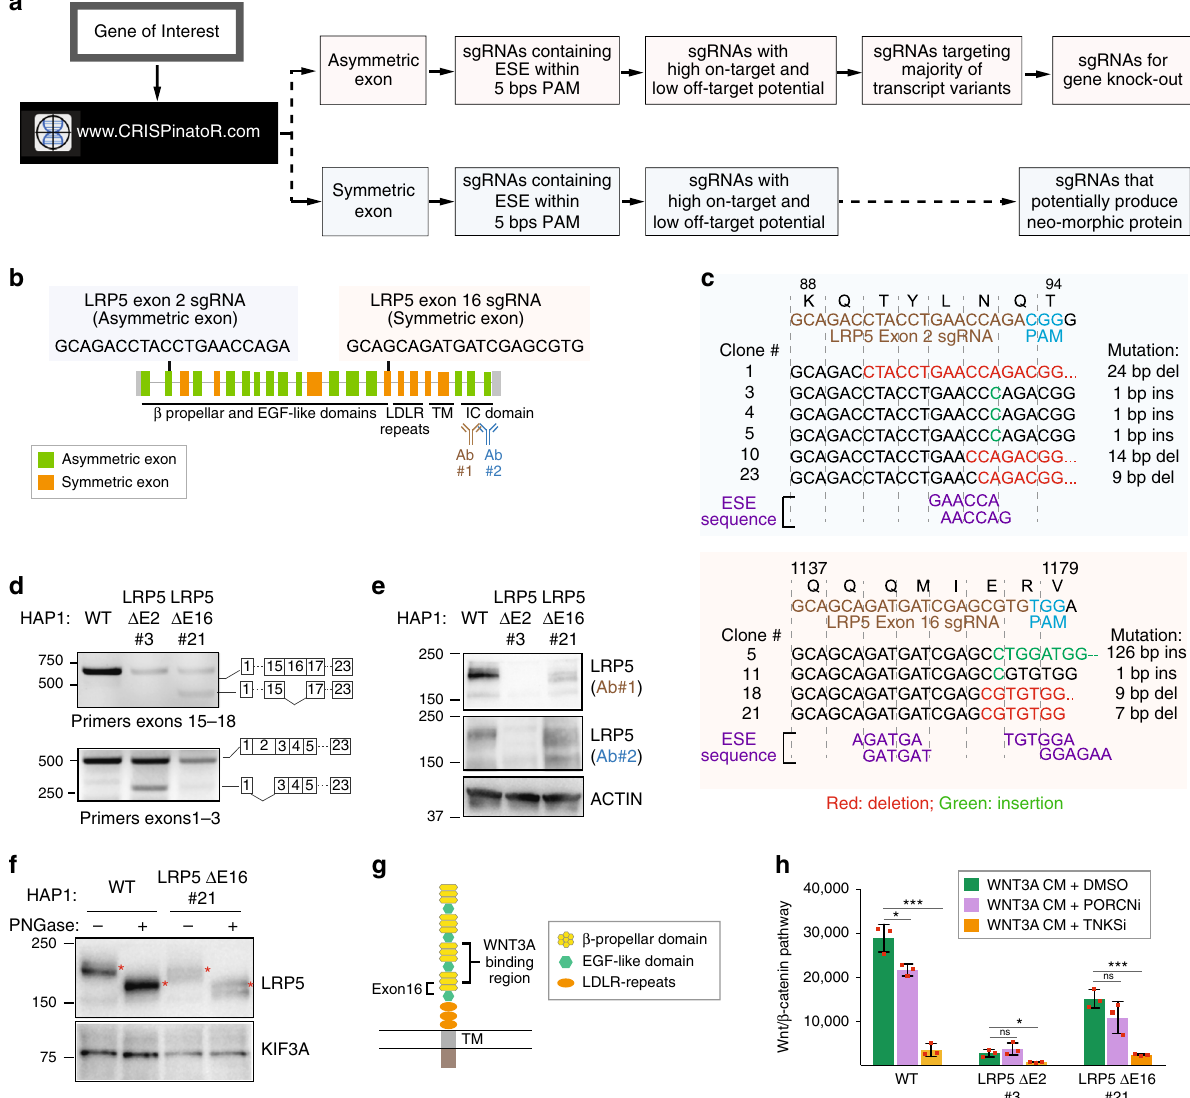
Fig. 5 Targeting RNA-regulatory elements for gene knockout agendas. a CRISPinatoR: a web-based guide RNA design tool that utilizes targeted ESE disruption for achieving gene elimination. CRISPinatoR identi fi es sgRNA sequences that target ESEs in asymmetric exons and calculates off-targeting potential and the number of splice variants impacted by the sgRNAs. A scoring system that integrates all three parameters is used to provide sgRNAs with high gene knockout potential. b Genome structure of the LRP5 gene and sgRNA sequences targeting the asymmetric exon 2 and the symmetric exon 16. c Genomic sequencing results of HAP1 clones edited using LRP5 exon 2 and exon 16 sgRNAs. CRISPR-introduced mutations and the putative ESE sequences are indicated. d Exclusion of an asymmetric or a symmetric exon with INDEL-induced changes to the putative ESE sequences. RT-PCR analysis and cDNA sequencing result of HAP1 cells edited with LRP5 exon 2 and exon 16 sgRNAs. e Targeted ESE disruption in asymmetric exon increases gene knockout potential. Western blot analysis of HAP1 clones edited with LRP5 exon 2 sgRNA (Clone 21) and exon 16 sgRNA (Clone 3) was probed with two distinct antibodies indicated in “ b ” . ESE disruption in symmetric exon 2 produces internally truncated in-frame LRP5 protein. f The internally truncated LRP5 protein is glycosylated. Lysates derived from WT or LRP5 Δ E16 HAP1 cells were incubated with the deglycosidase PNGase F then subjected to western blot analysis. g Exclusion of LRP5 exon16 would delete a sequence adjacent to the WNT3A binding domains. h The LRP5 Δ E16 protein formed post skipping of a symmetric exon is functionally active. WNT/ β -catenin pathway activity in response to WNT3A conditioned medium (WNT3A CM) was measured for HAP1 WT, LRP5 Δ E2, and LRP5 Δ E16 cells. WNT pathway inhibitors WNT974 (PORCNi) and IWR1 (TNKSi) serve as negative and positive control, respectively. All error bars represent mean of triplicates ± s.d. The experiment was repeated three times with similar results. Statistical testing was performed using Student ’ s t -test, * P < 0.05, ** P < 0.01, *** P < 0.001, **** P < 0.0001. Source data are provided as a Source Data fi for evaluating the potential effects of INDELs on mRNA regulation. Materials and methods INDELs. All the cell lines were tested for mycoplasma contamination. None of the Cell lines and reagents . WT and CRISPR-edited HAP1 knockout commercial cell cell lines were authenticated since all the cell lines were directly purchased from commercial suppliers. lines were purchased from Horizon Discovery (Supplemental Table 1). HELA, MIA